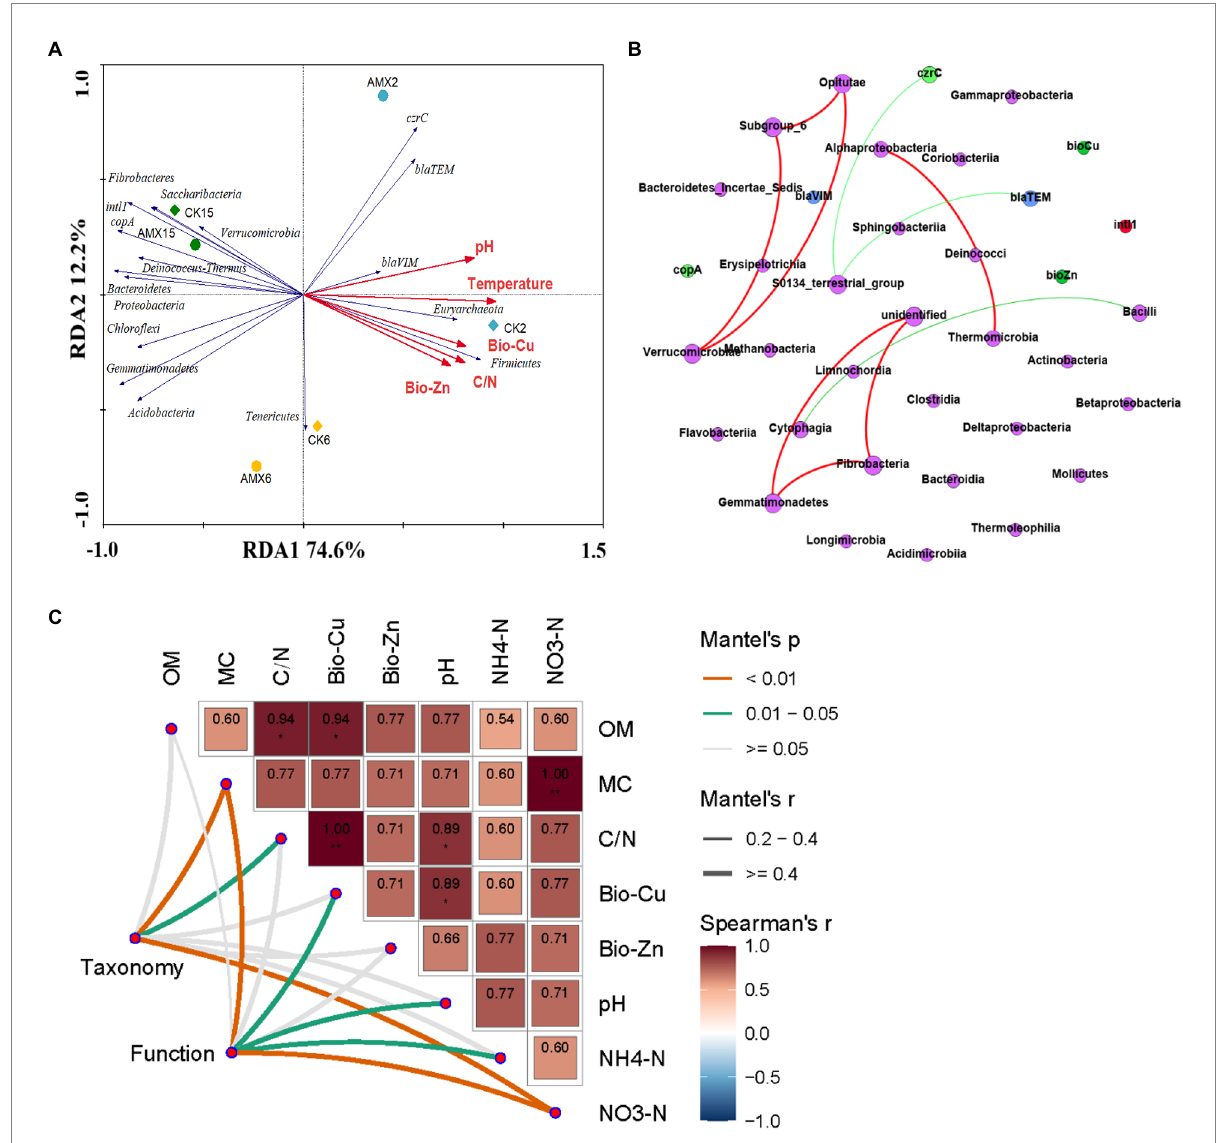
FIGURE 5 Environmental drivers of compost microbial community composition: (A) RDA of the relationships between the main bacterial phylum (more than 1% of the total bacterial abundance, blue arrows) and environmental factors (red arrows), (B) network analysis of the relationships among class- level bacteria (purple nodes), ARGs (blue nodes), MRGs (light green nodes), HMs (green nodes), and intI1 (red nodes), and (C) pairwise comparisons of environmental factors were shown, with color gradients representing Spearman’s correlation coefficients. Taxonomic (based on family-level bacteria) and functional (based on ARGs, MRGs, intI1 , ARB, TCB, and ARB/TCB) community composition was related to each environmental factor by Mantel tests. Edge width denotes the Mantel’s r statistic for the corresponding distance correlations, and edge color represents the statistical